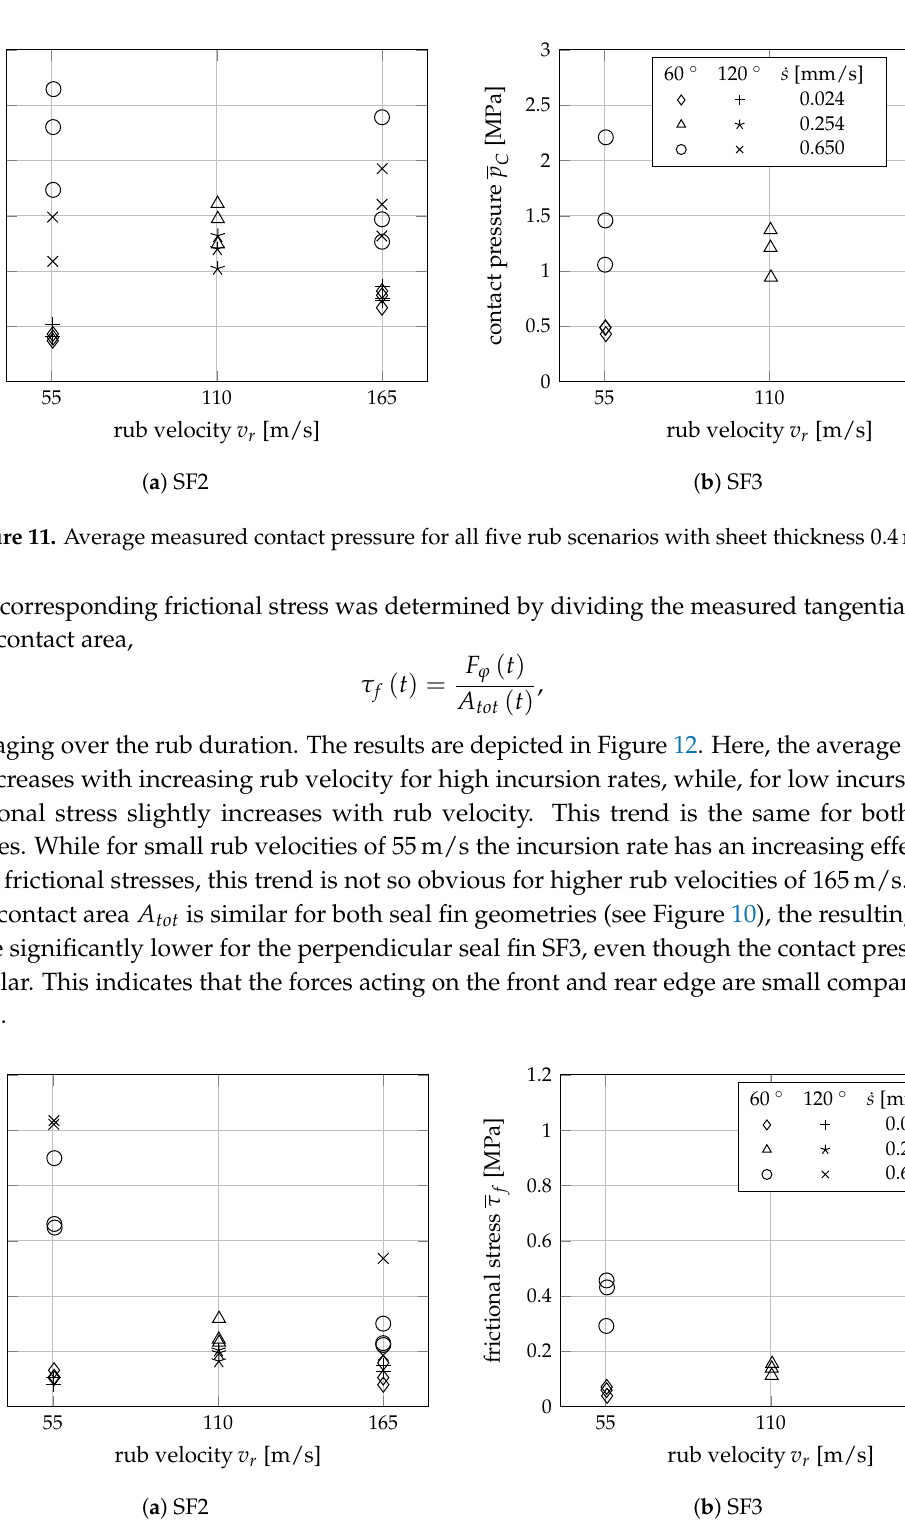
Figure 12. Average measured frictional stress for all five rub scenarios with sheet thickness 0.4 mm for ( a ) the inclined seal fin (SF2) and ( b ) perpendicular seal fin